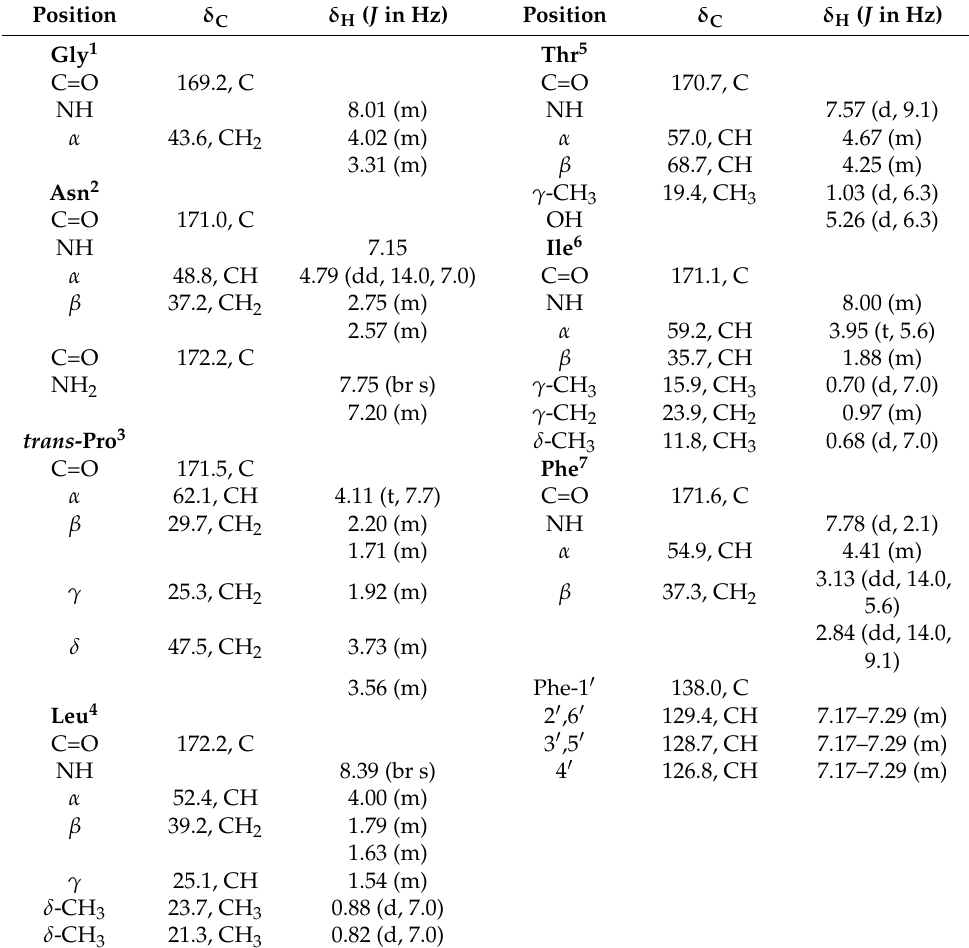
Table 5. 1 H and 13 C NMR data for dianthiamide E ( 5 ) (DMSO- d 6 , 700 MHz, d in ppm, J in